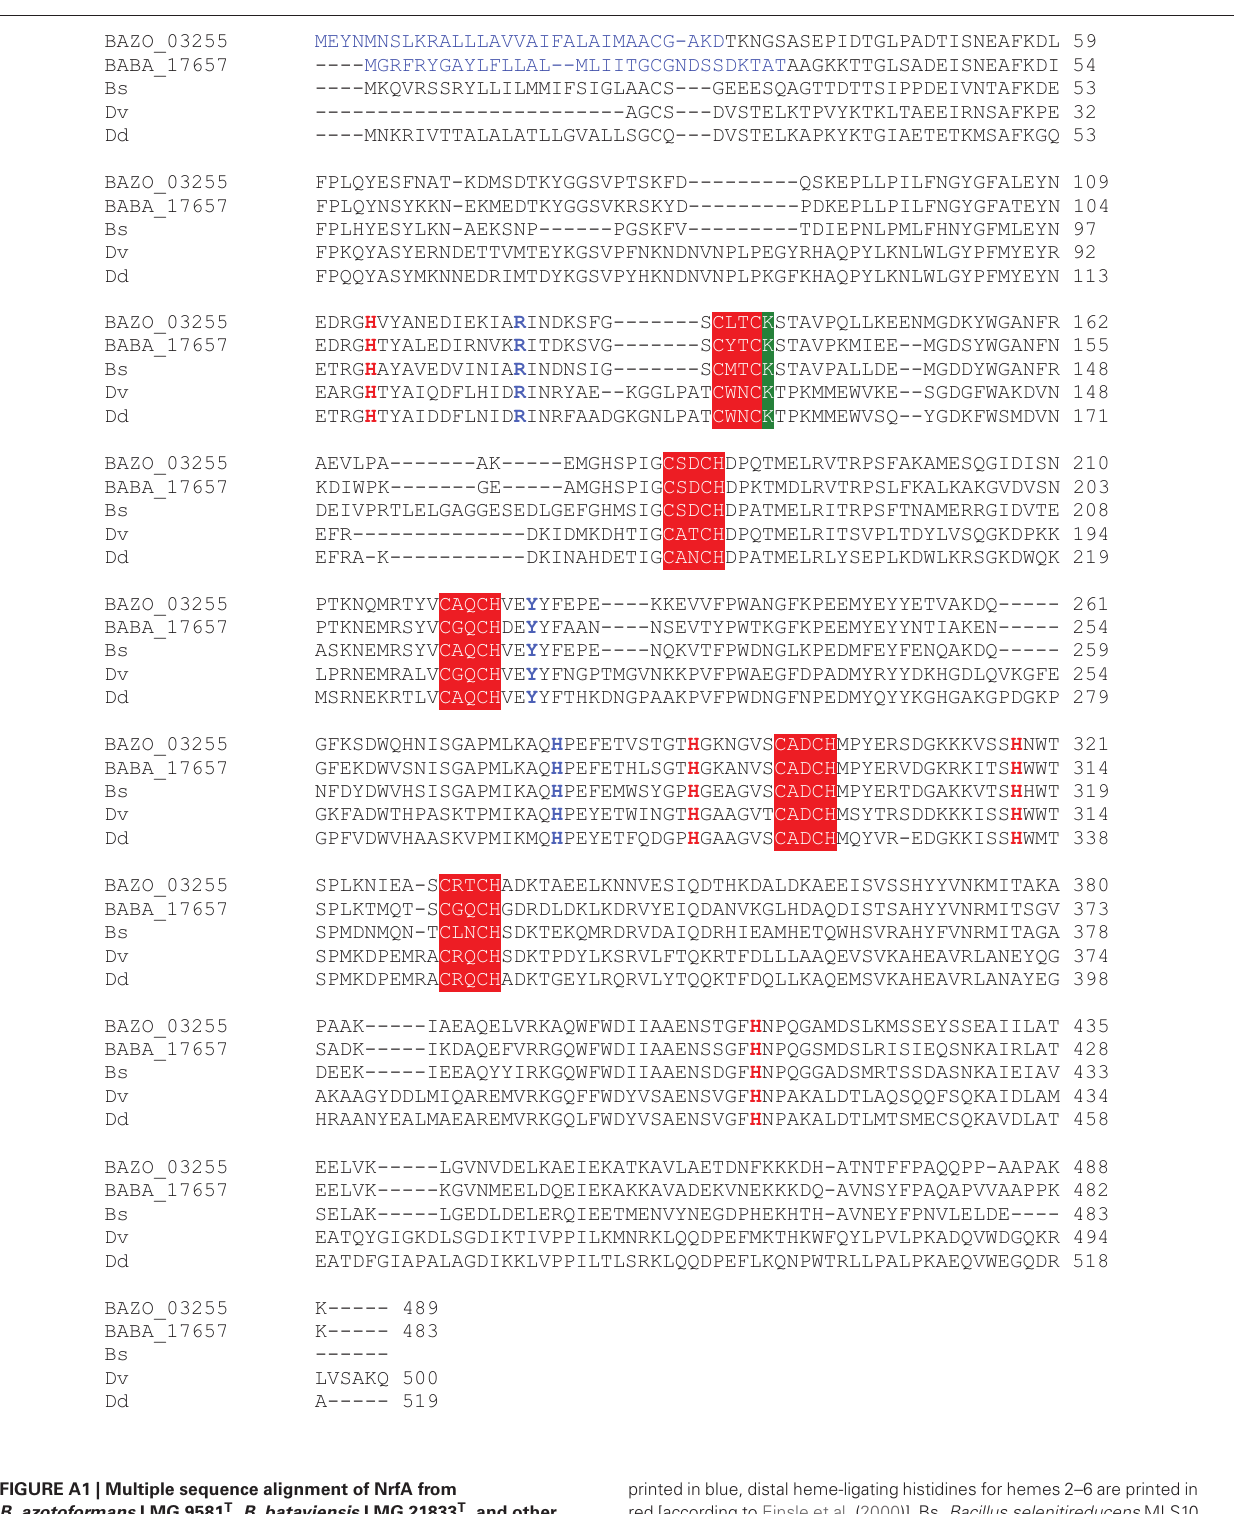
FIGURE A1 | Multiple sequence alignment of NrfA from B. azotoformans LMG 9581 T , B. bataviensis LMG 21833 T , and other bacteria. Heme-binding motifs are highlighted in red (white lettering), the lysine at the catalytic heme is highlighted in green, active site residues are